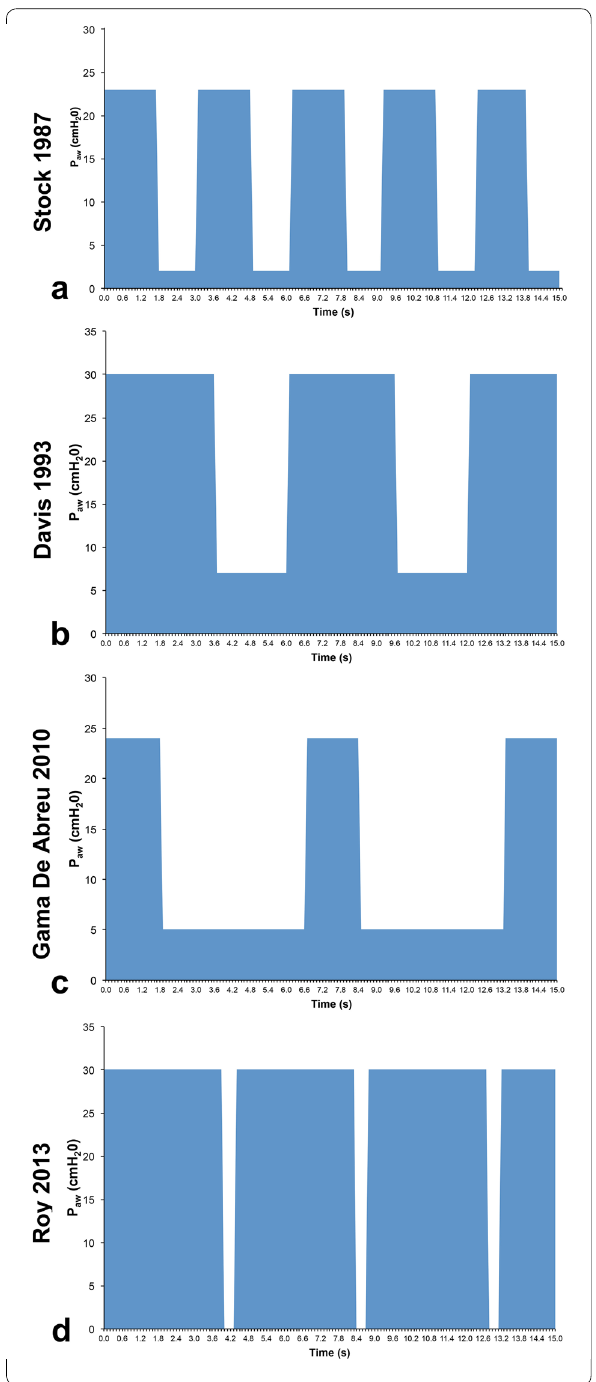
Fig. 1 Airway pressure/time waveforms from published papers [12] all using the airway pressure release ventilation (APRV) mode but with different methods: a Stock et al. used a CPAP phase that encompassed 60% of each breath, a release phase of 1.27 s and a respiratory rate (RR) of 20/min [98]; b Davis et al. decreased the respiratory rate by prolonging both the CPAP and release phase